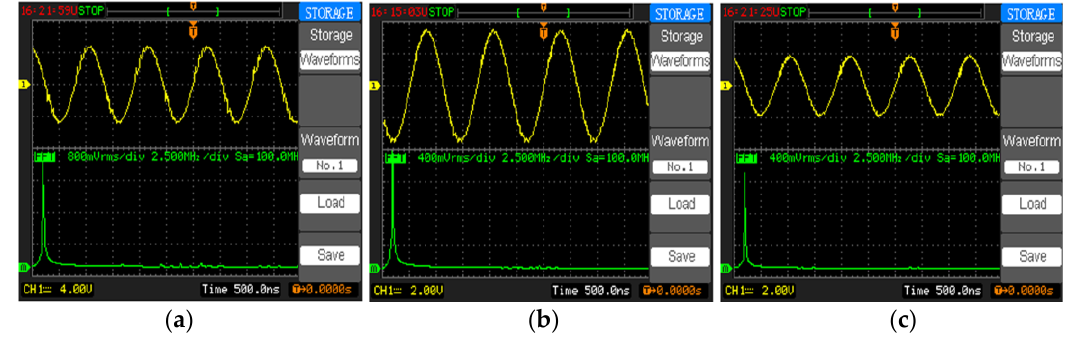
Figure 9. Waveform and frequency spectra of ( a ) a source circuit measured at the source coil; ( b ) measured signals at the receiver coil for the system with a resistive load of 100 Ω at 6 cm; and ( c ) measured signals at the receiver coil for the system with a resistive load of 100 Ω at 15 cm.